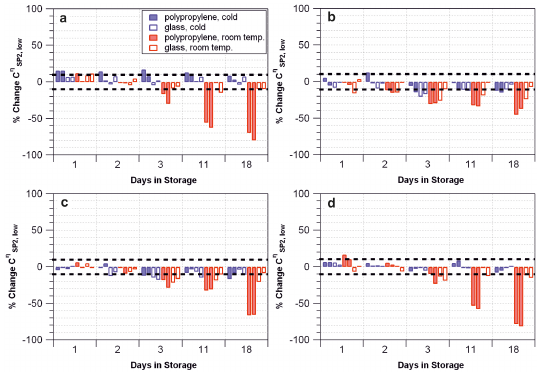
Figure C1. BC concentrations in (a) environmental snow, (b) AQ ∼ 15µgL − 1 , (c) AQ ∼ 10µgL − 1 and (d) AQ ∼ 3µgL − 1 samples tracked for 18 days in various storage conditions. The bars express the BC concentration on a given day as a percentage of the origi- nal BC concentration (before any losses due to storage; not shown). Each bar represents one sample. Black dotted lines indicate the re- peatability of the SP2, assuming no sample